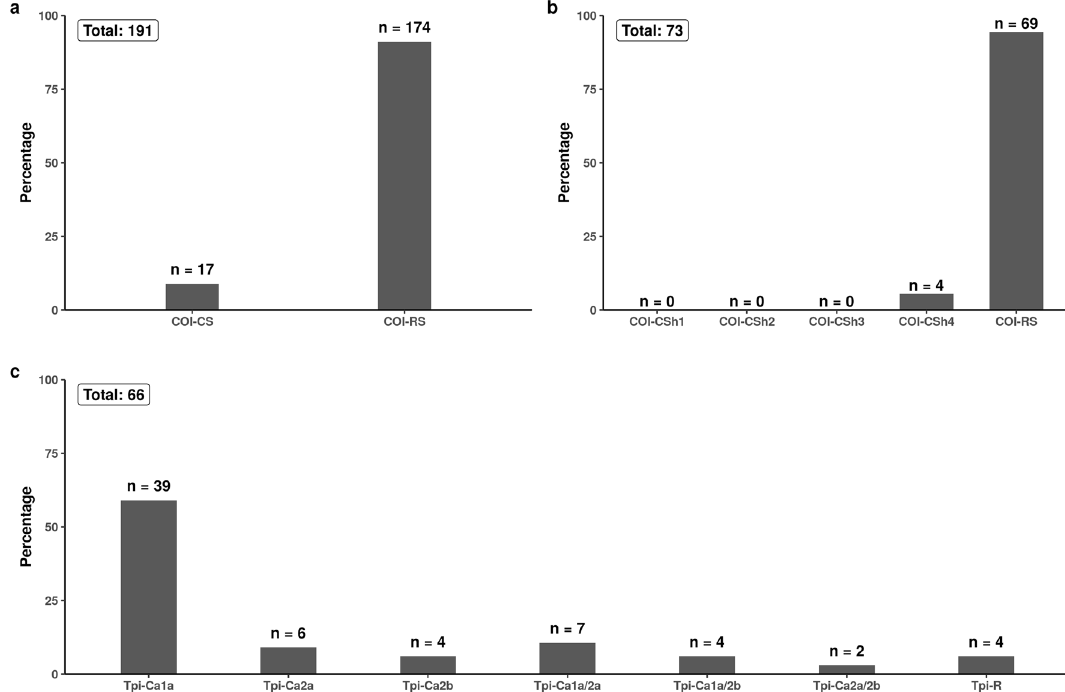
Figure 2. Strain distribution for FAW populations in India based on mitochondrial gene COI and Tpi gene markers. ( a ) COIA distribution; ( b ) COIB distribution; ( c ) Tpi